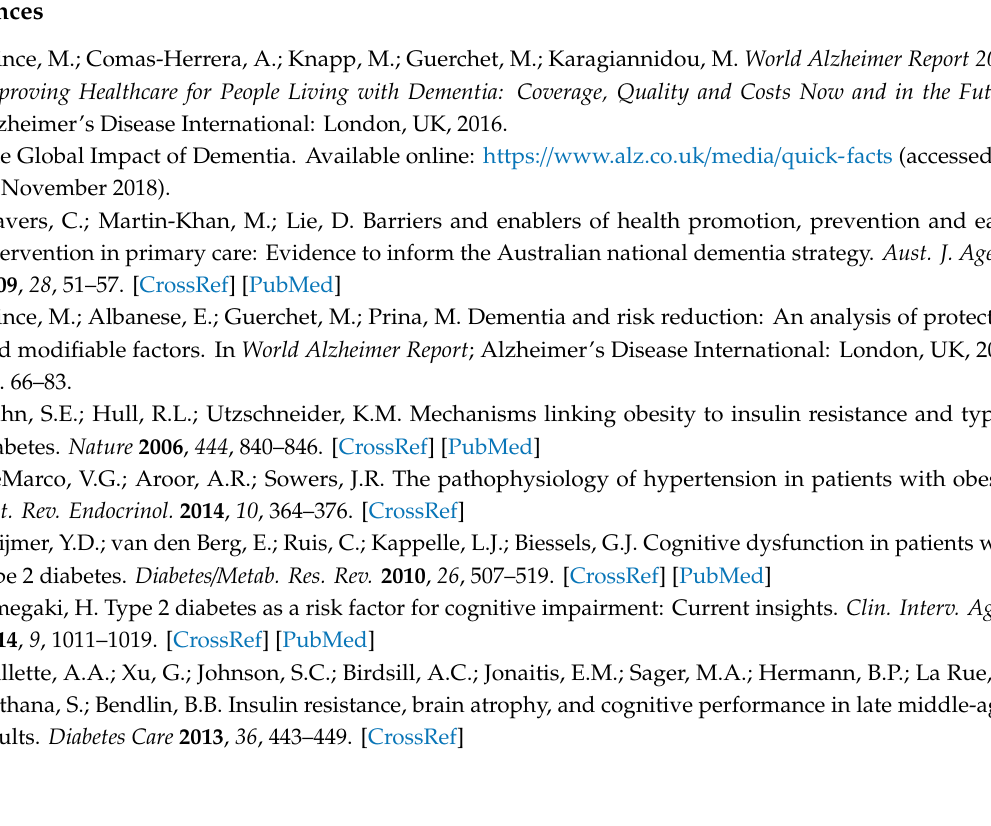
Figure S1: Memory retention, total brain weight, and A β 1–42 accumulation in SAMR1 and SAMP8 mice at 2 months of age. Figure S2: Synapse-associated protein levels in SAMP8 mice at 6 months of age. Figure S3: E ff ects of GTEs intake on NEP levels in SAMP8